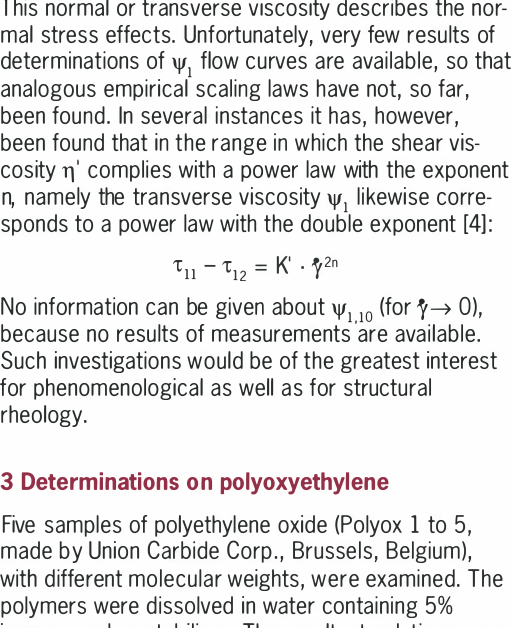
Scaling laws for T]0, y